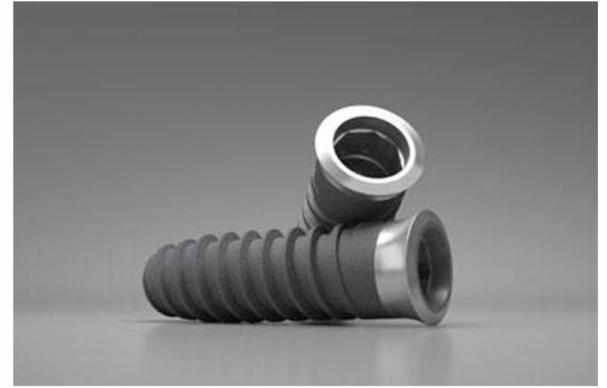
Figure 1. Essential implants by Klockner used in the